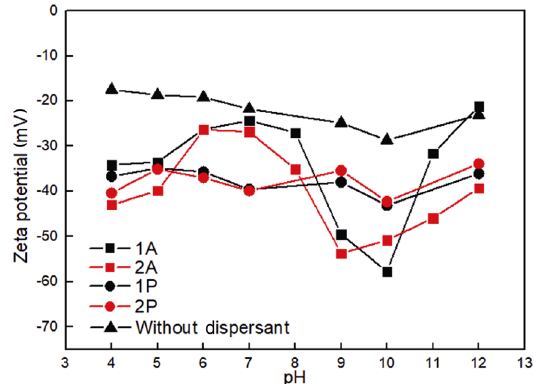
Fig. 6 1A10 green compacts and sintered samples (a) with and (b) without Al 4 C 3 embedding powders ranging from 1350 to 1500 ℃